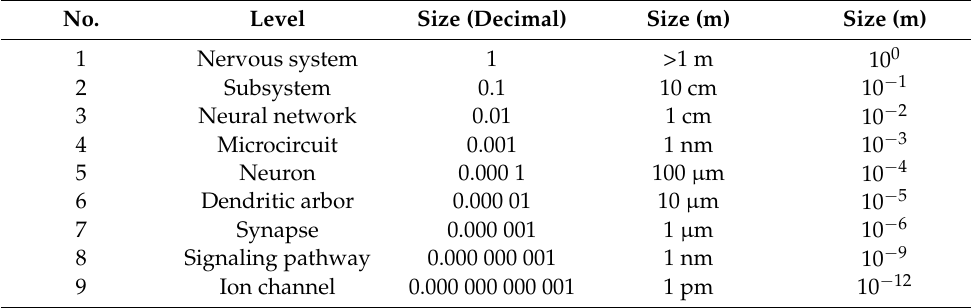
Table 1. Levels of organization in the brain (Adapted from